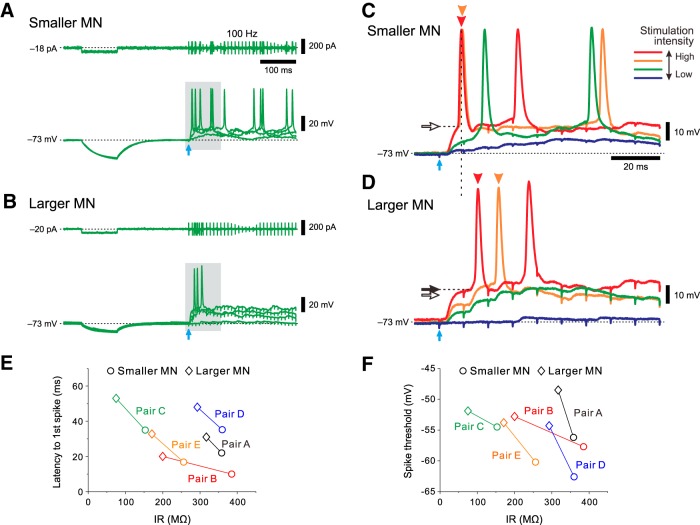
IR-dependent activation/recruitment of MNs in the dl-TMN. A, B, Membrane potential responses to hyperpolarizing current pulses and those evoked by 100 Hz stimulation of presumed Ia afferents in the smaller and larger MNs (A and B, respectively). C, D, The enlarged traces of the responses (gray area in A and B, respectively) in the smaller and larger MNs (C and D, respectively). E, The relationship between IRs and latencies to the first spikes in five pairs of MNs of different sizes when the difference in the latency to the first spike between the pair of smaller and larger MNs became maximum. F, The relationship between IRs and spike thresholds in five pairs of MNs of different sizes.